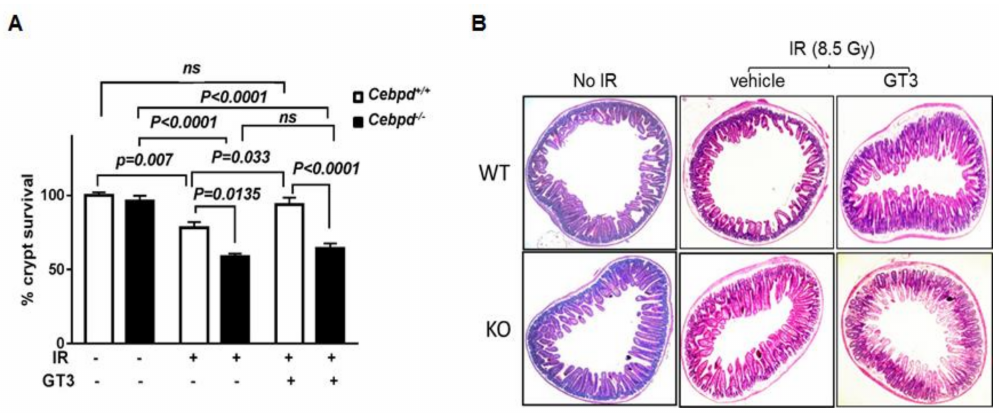
Figure 2. GT3 treatment did not rescue Cebpd − / − mice from radiation-induced loss of intestinal crypts. ( A ) Surviving crypts were scored in Cebpd + / + and Cebpd − / − mice that were un-irradiated and or vehicle- and or GT3-treated 24 h prior to exposure to 8.5 Gy. Data are expressed as mean + S.E.M. and obtained from n = 7–8 mice/genotype/group. p < 0.05 was considered statistically significant; ns , not significant ( B ) Representative hematoxylin and eosin stained transverse sections of small intestine (jejunum) showing the crypts and villi harvested at day 3.5 post 8.5 Gy